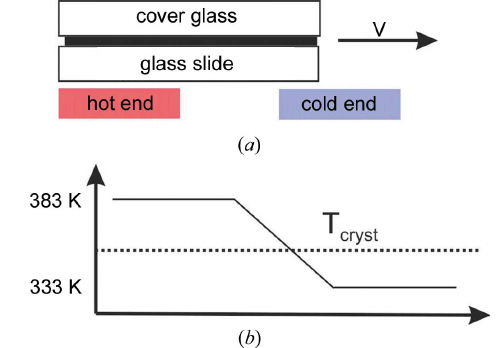
Figure 1 ( a ) Schematic picture of the gradient crystallization set-up where a layer of terthiophene squeezed between two glass plates is drawn with the velocity v across a temperature gradient. ( b ) The temperature distribu- tion across the set-up with the crystallization temperature of terthiophene ( T cryst ) located between the two heated